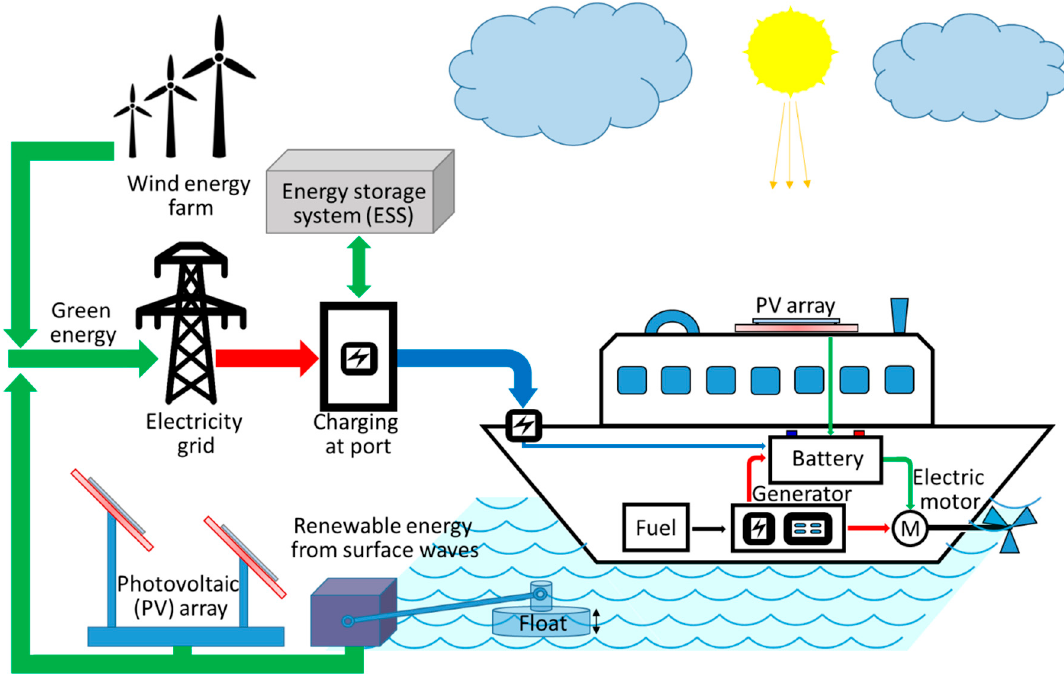
Figure 1. An eco-friendly hybrid propulsion system.